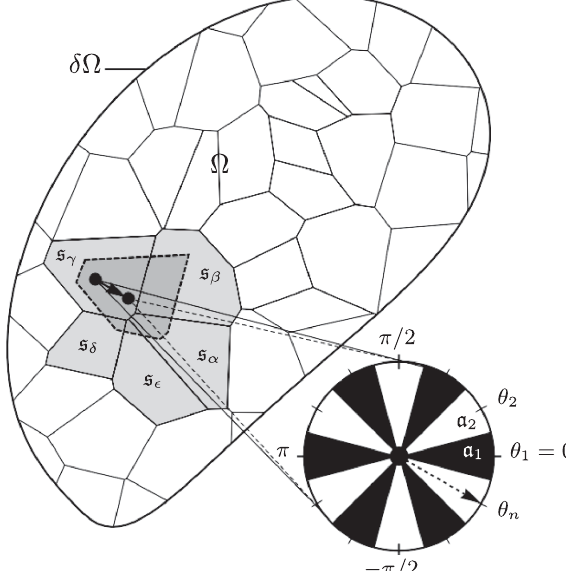
FIG. 1. Spatial and angular tessellations: The system ’ s spatial domain Ω is discretized using an arbitrary tessellation f s α g α obeying Eqs. (7). A set of angular channels according to the tessellation (9) is attached to each spatial cell s γ . Spatial transport: Convection in the bulk of the system along the direction θ n (indicated by the dashed arrow) amounts to translating each spatial cell s γ by the convection length τ . The convective transport operator T α k [Eq. (16b)] then redistributes the current n γ value of f γ n among all neighboring cells according to their intersection with the convected